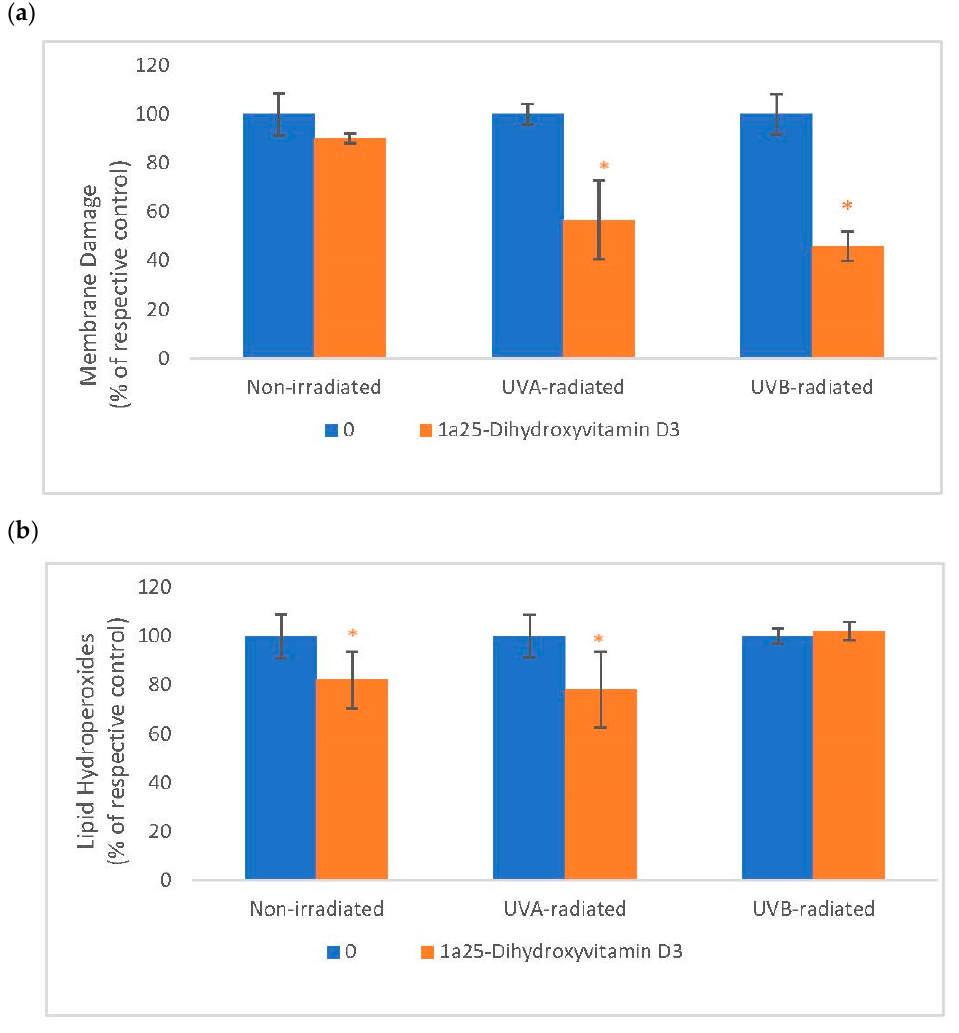
Figure 5. The effect of 1 α , 25dihydroxyvitamin D3 (vitamin D) on Membrane Damage and Lipid Peroxidation in non-irradiated, UVA-radiated, and UVB-radiated fibroblasts. Non-irradiated, UVA-radiated, or UVB-radiated fibroblasts were incubated with vitamin D (0 or 0.2 µM) and examined for membrane damage by LDH assay (Sigma, Ronkonkoma, NY, USA) ( a ), and for lipid hydroperoxides by Peroxi detect kit (Sigma) ( b ). * = p < 0.05, relative to respective controls. Error bars represent standard deviation, n = 4.